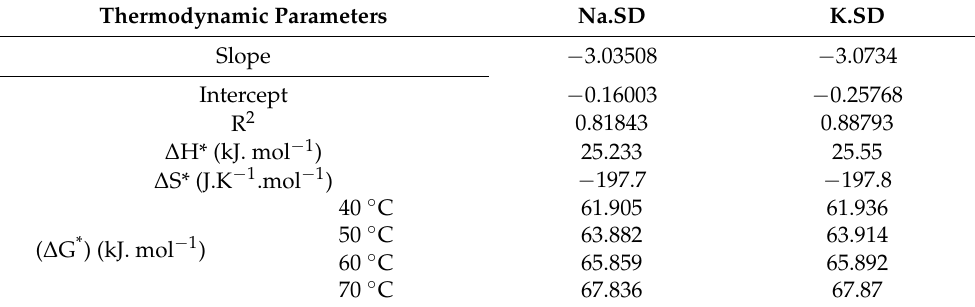
Table 5. The estimated thermodynamic functions of Na.SD and K.SD transesterification systems. Thermodynamic